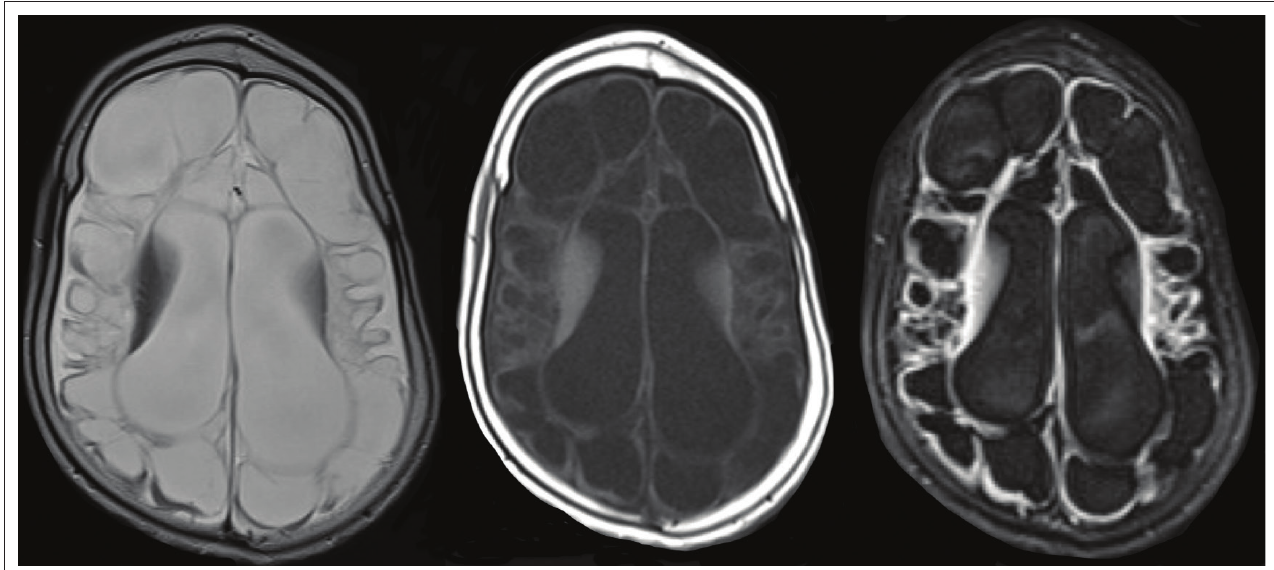
FIGURE 25: A 3-year-old male child with spastic cerebral palsy and blindness. Recorded neonatal encephalopathy with low Apgar scores and neonatal seizures. Axial T2- weighted, T1-weighted and FLAIR sequence images show extensive cerebral destruction with grey and white matter injury, cystic encephalomalacia and ex vacuo dilatation of the lateral ventricles.